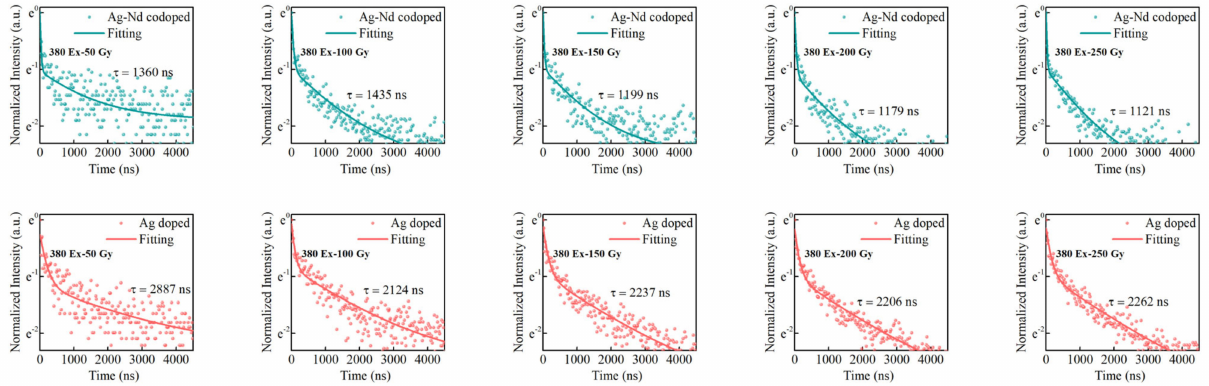
Figure 9. The RPL lifetime of Ag defect centers at 650 nm in Ag-doped and Ag–Nd-codoped phosphate glasses at different radiation doses (380 nm excitation). Table 3. Background doses lifetime τ 1 and RPL lifetime τ 2 of Ag-doped and Ag–Nd-codoped phosphate glasses; energy transfer efficiency η from Ag defect centers to Nd 3+ ions in